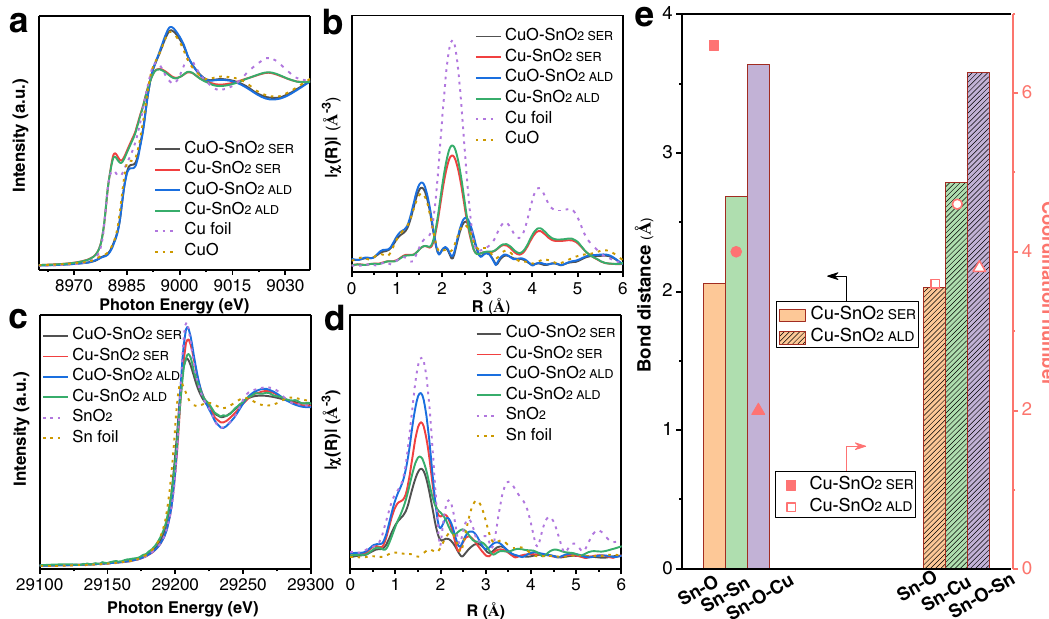
Fig. 3 | X-ray absorption spectroscopy analysis. The Cu K-edge XAS features of two as-prepared CuO-SnO 2 samples, two pre-reduced Cu-SnO 2 catalysts and two Cu standards (Cu foil and CuO) at the ( a ) near-edge and ( b ) post-edge after Fourier transform. The Sn K-edge XAS features of two as-prepared CuO-